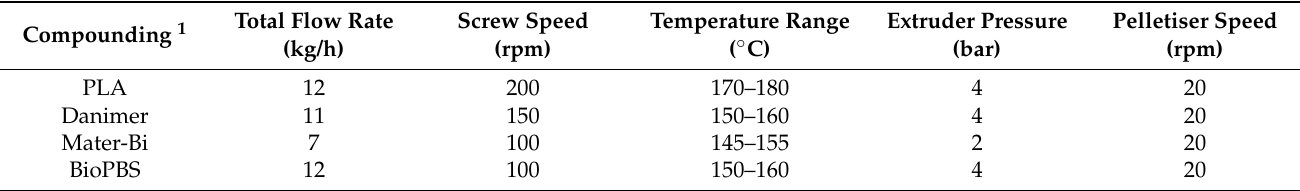
Table 9. 1st film generation compounding extrusion parameters.